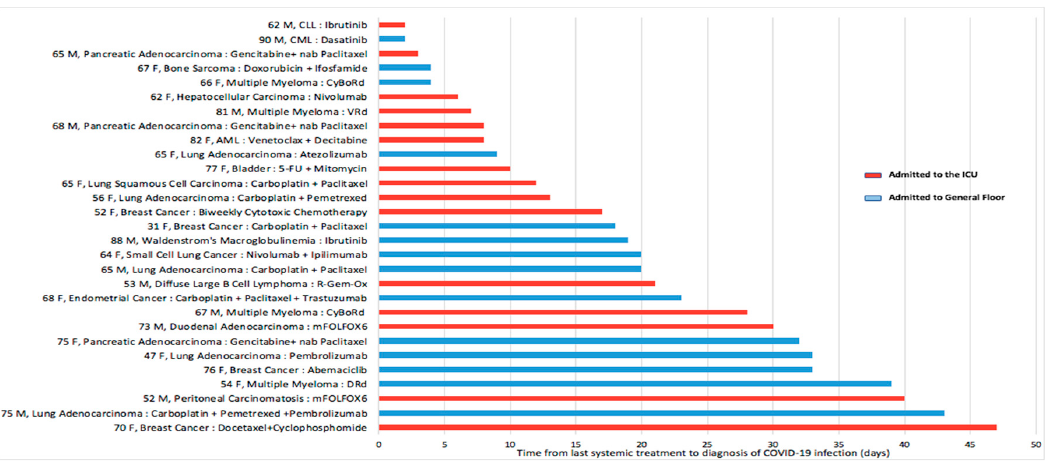
Figure 2. Non ‐ hormonal systemic therapy, time to coronavirus disease 2019 (COVID ‐ 19) infection, and type of hospitalization in 29 hospitalized patients. Abbreviations used in this figure were list in Table S1.